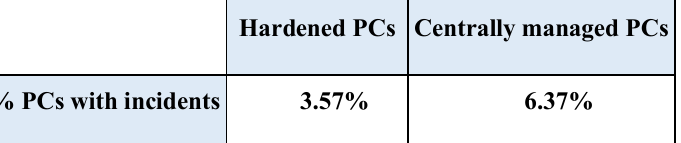
Table 1. Percentage of Antivirus detections on